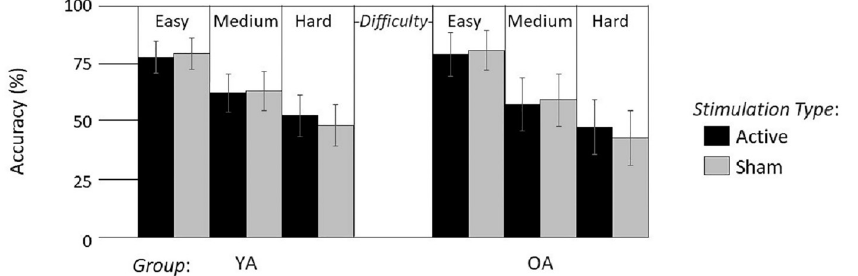
Fig 6. Mean accuracy in the Invalid trials for active (dark grey) and sham (light grey) rTMS and for each difficulty level, for young (YA) and older adults (OA). Error bars represent the standard error.